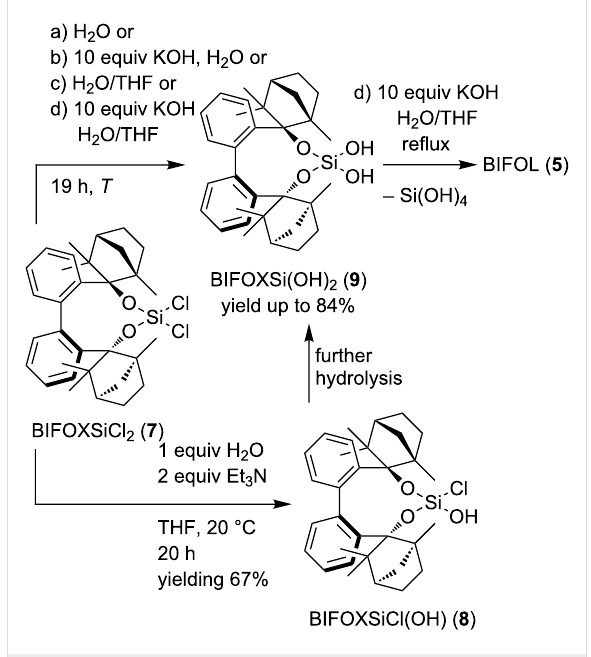
Table 1, Scheme 3d). By increasing the temperature to 50 °C the hydrolysis increases, resulting in 32% yield in H 2 O/THF and 64% yield in H 2 O/THF/KOH (Table 1, Scheme